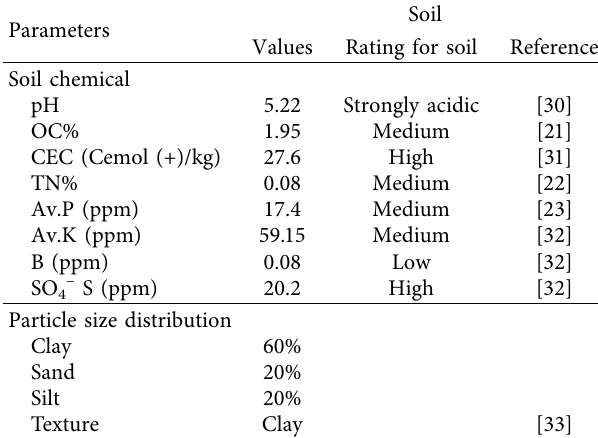
Table 2: Selected soil physicochemical properties of experimental site.